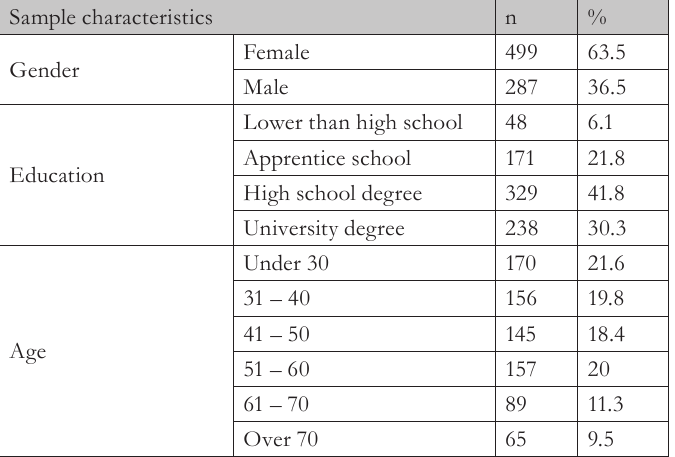
Tab. 2 – Sample characteristics of the primary research (Source: own survey)